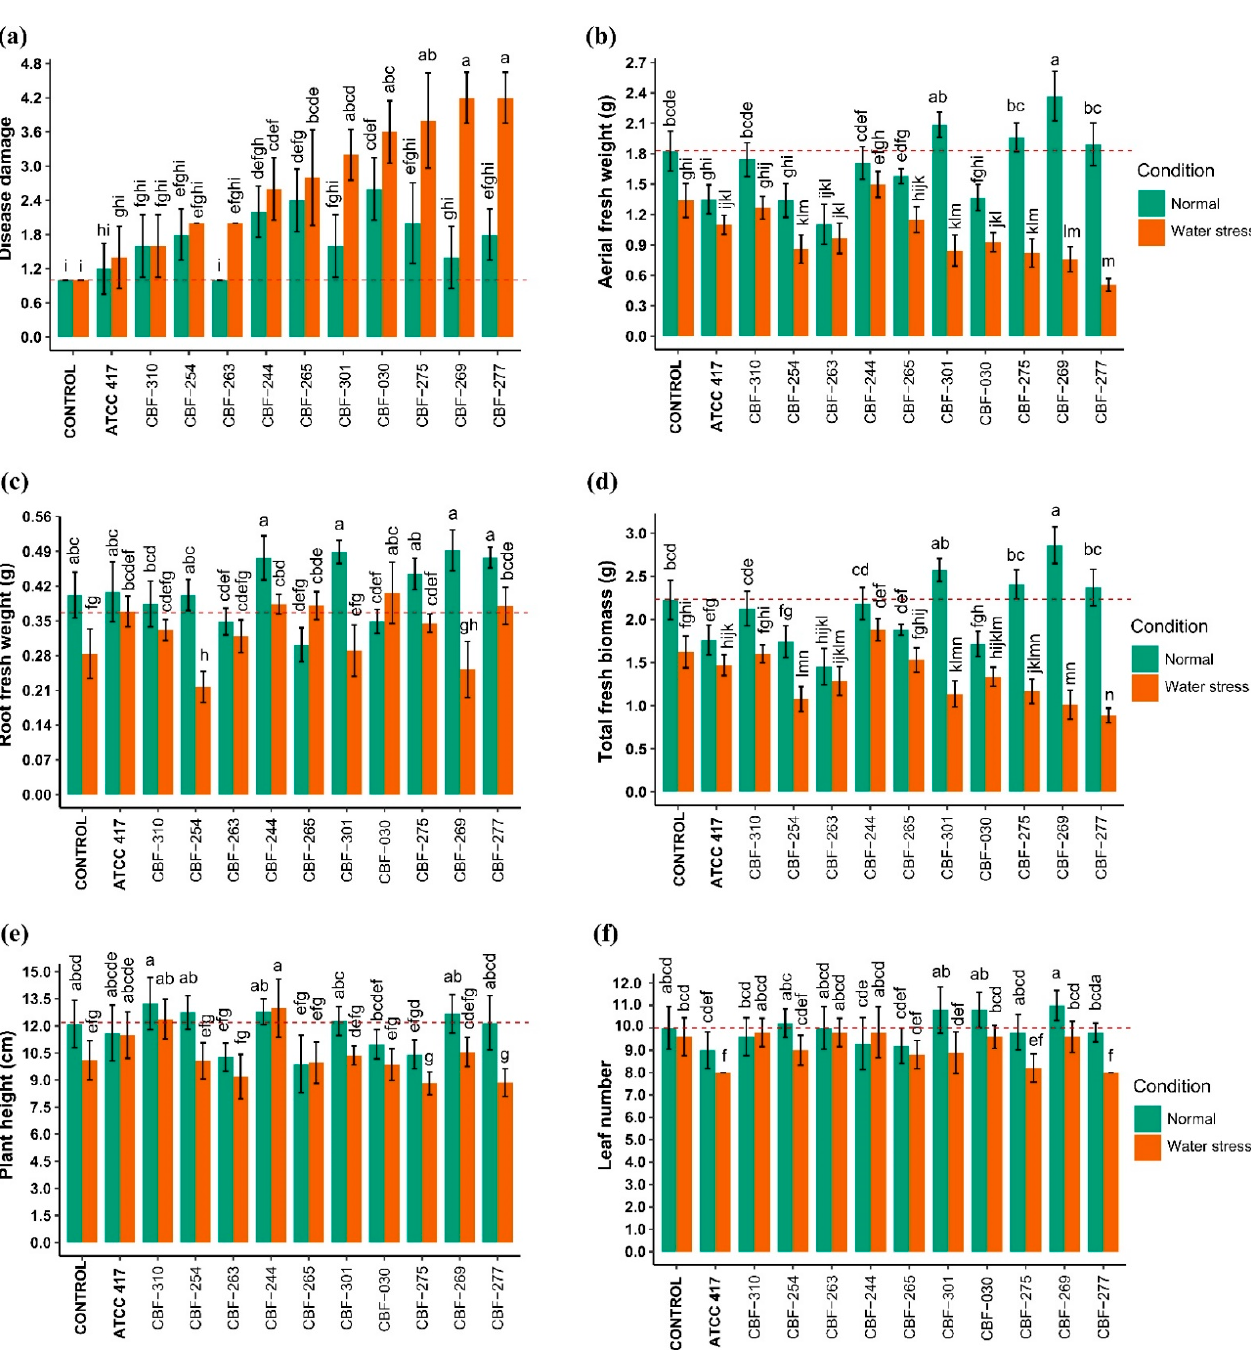
Figure 3. Effects of Fusarium isolates on disease damage and agronomical parameters of coffee seedlings. ( a ) Disease damage; ( b ) aerial fresh weight; ( c ) root fresh weight; ( d ) total fresh weight; ( e ) plant height; ( f ) leaf number. Data points represent mean ± SD ( n = 5). Treatments sharing one or more letters are not significantly different ( p < 0.05). Red dotted lines indicate control average.